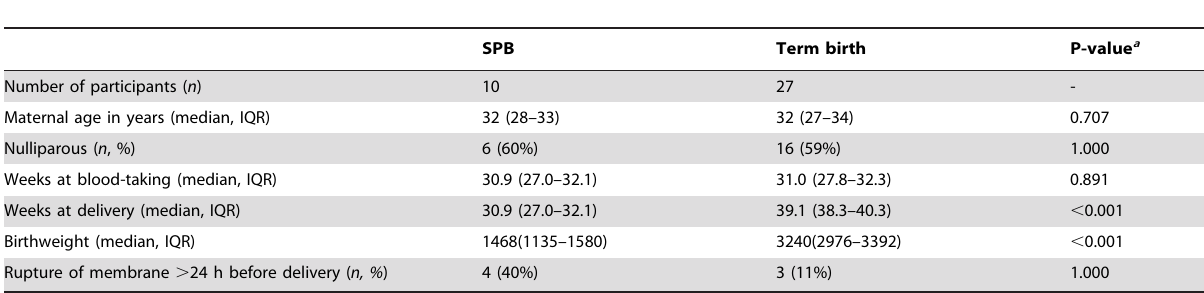
Table 2. Characteristics of participants in the analysis of maternal plasma samples.